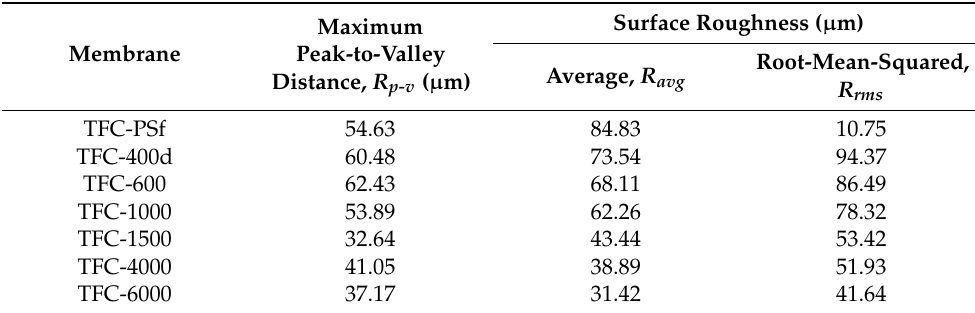
Table 2. Maximum peak-to-valley distances, average surface roughness and root-mean-squared roughness for the TFC PA/PSf-PEG membranes with different M w of